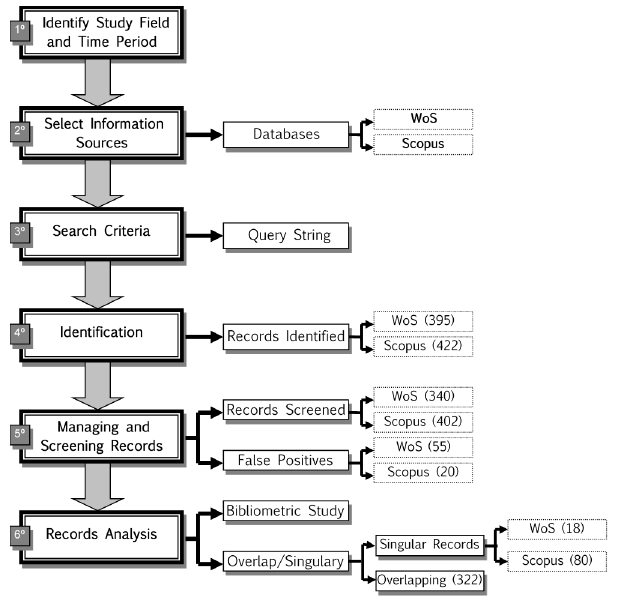
Figure 2. Research stages. Source: Own elaboration.